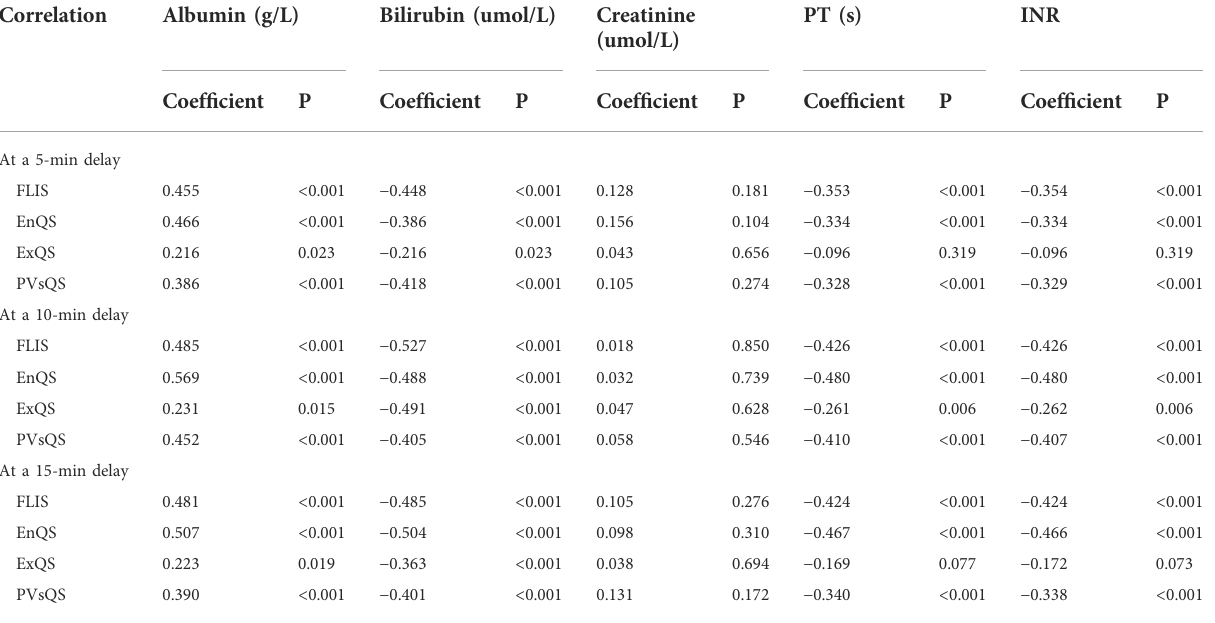
TABLE 6 Correlations to clinical parameters for FLIS at different time